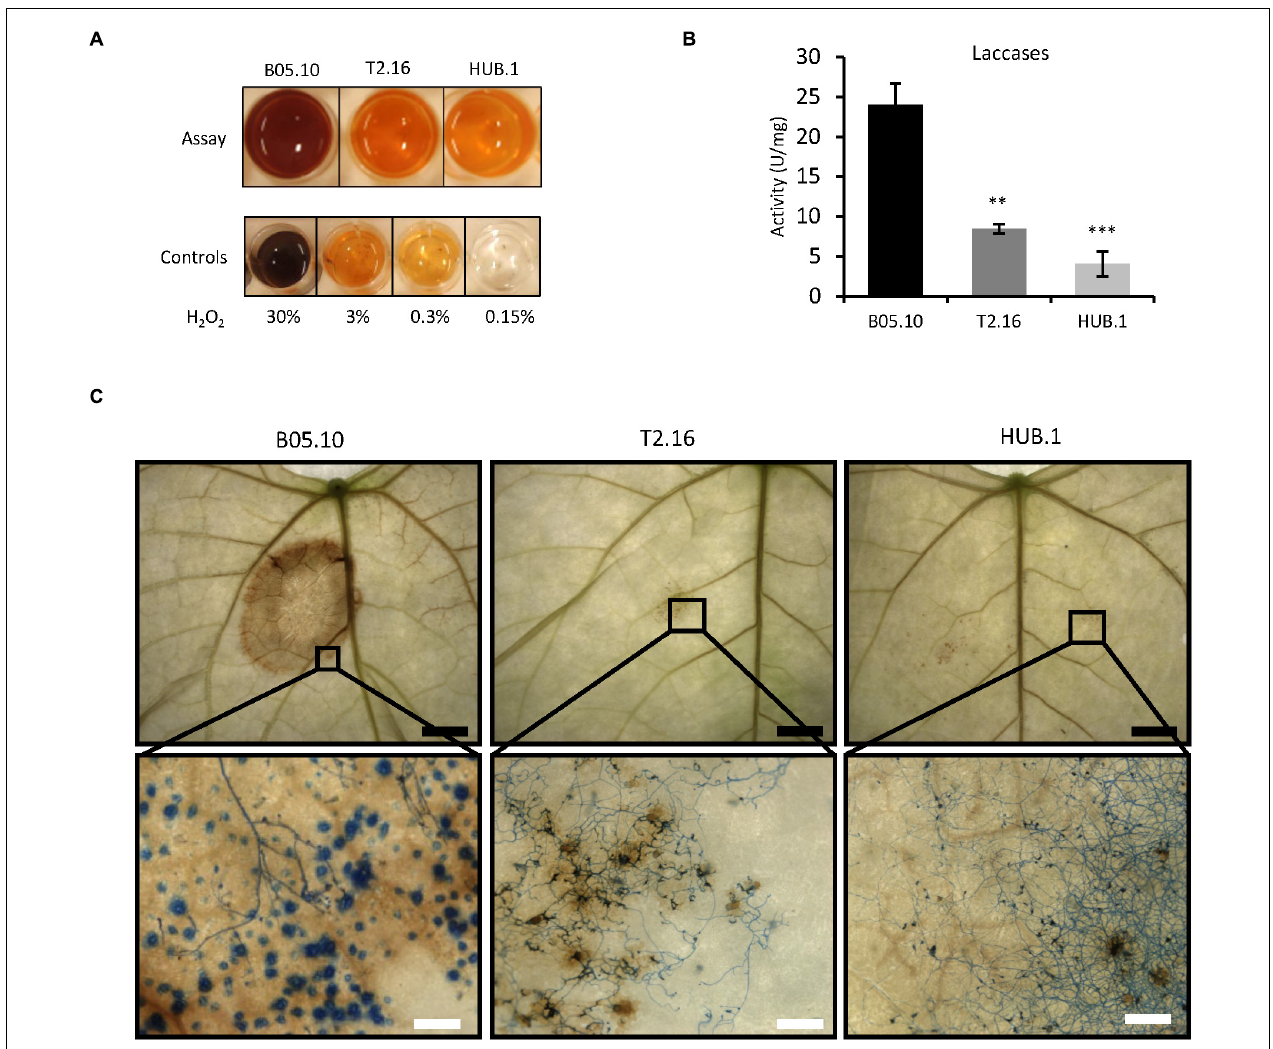
FIGURE 4 | Secretion of ROS in the clathrin mutants. (A) Production of ROS in vitro . Equal quantities of mycelia from the parental (B05.10) and mutant (T2.16 and HUB.1) strains were incubated 2 h in the presence of soluble colorless DAB. DAB oxidation into a brown precipitate was monitored and compared to controls using defined quantities of H 2 O 2 . (B) Laccase activities measured in the supernatant of liquid cultures in CCPX medium at 72 h for the parental (B05.10) and the mutant (T2.16 and HUB.1) strains. Activities are expressed in arbitrary units (U) per mg of mycelium, three independent biological replicates were performed. Standard deviations are indicated, and asterisks indicate significant difference compared to the B05.10 strain (Student’s t -test p -value ∗∗ < 0.01; ∗∗∗ < 0.001). (C) ROS detection in planta . Primary bean leaves were inoculated with conidia of the parental (B05.10) and mutant (T2.16 & HUB.1) strains and stained with DAB and cotton blue in lactic acid (beta-glucan targeting dye) at 72 h post-infection. DAB oxidation into brown precipitates and hyphal coloration were monitored using a macroscope at different magnifications (black scale bar 5 mm; white scale bar 200 µ m). Blue dots in the parental sample could represent callose depositions by the plant (also made of